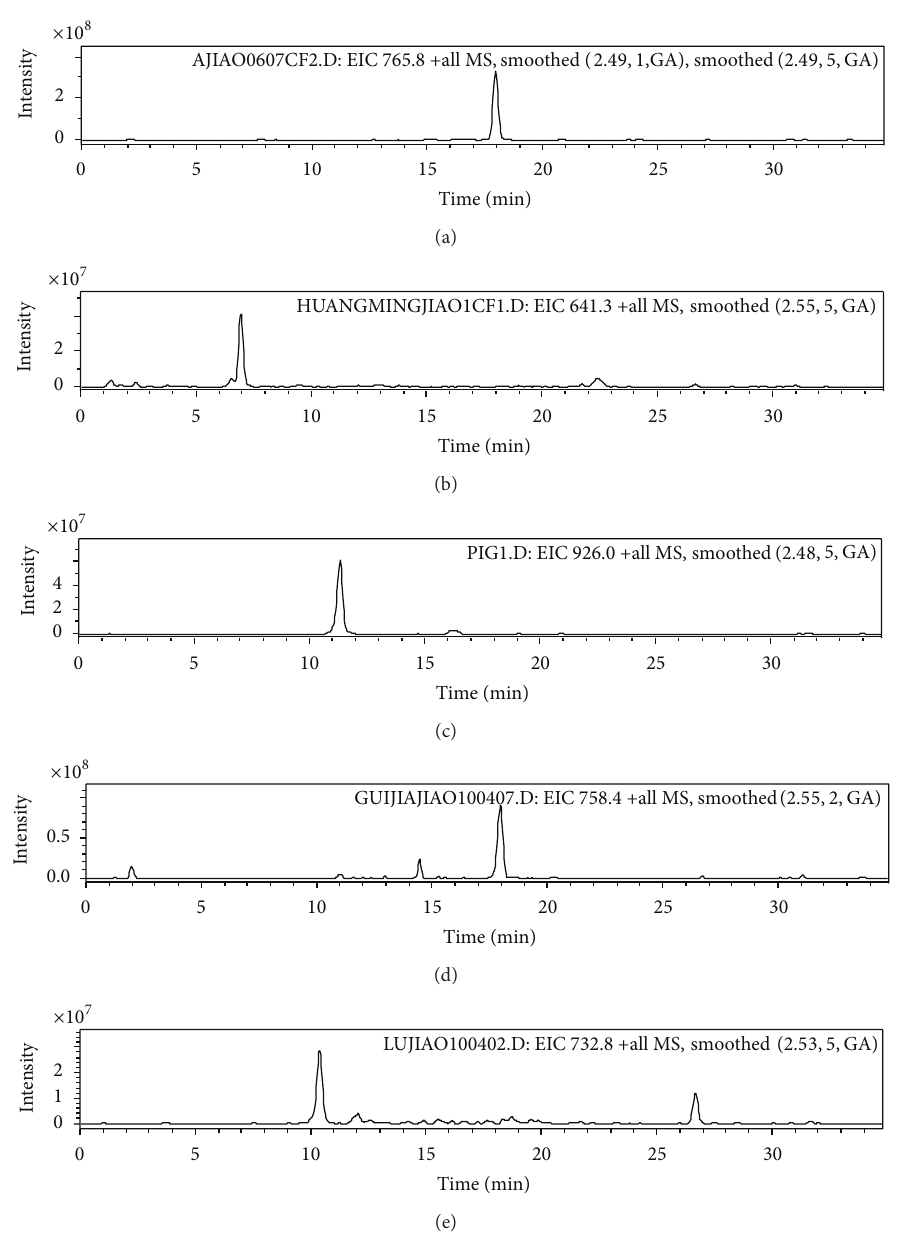
Figure 2: Doubly charged selected ion chromatograms obtained from the tryptic digest analysis of (a) donkey-hide gelatin, (b) bovine-hide gelatin, (c) pig-hide gelatin, (d) tortoise shell glue, and (e) deerhorn